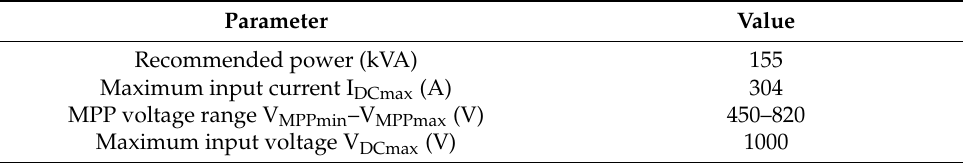
Table A4. Electrical characteristics of the solar